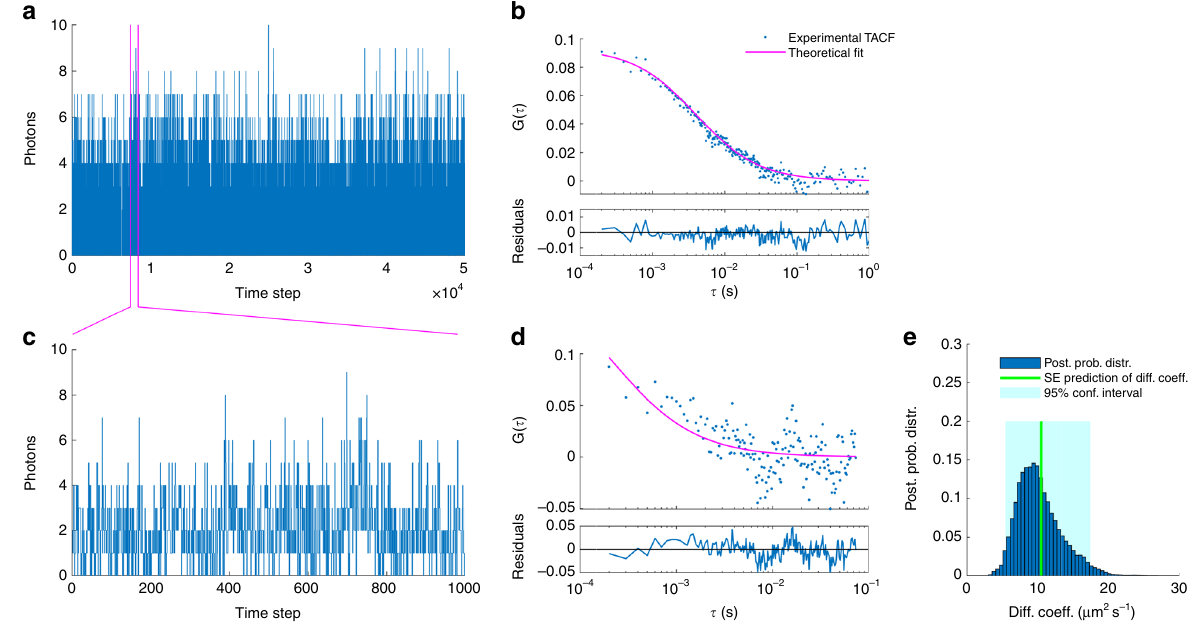
Fig. 4 Traces of free fl uorescent beads using an elongated confocal volume. a Experimental fl uorescent intensity trace used in FCS. b Autocorrelation curve of the trace in a and best theoretical fi t. c Portion of the trace in a to be used as the input to FCS and our method. d Autocorrelation curve of trace in c . e Posterior probability distribution over the diffusion coef fi cient estimated from the trace in c . The Stokes – Einstein prediction is denoted by a green line. Traces shown in a and c are acquired at 100 μ s for a total period of 5 μ s and 0.1 μ s, respectively. The laser power used to generate the trace a is 100 μ W (measured before the beam enters the objective). The estimate of diffusion coef fi cient resulting by autocorrelation fi tting in a matches with the Stokes – Einstein prediction (i.e., 10.5 μ m 2 s − 1 ); whereas, in d is almost 10-fold higher (~ 10 μ m 2 s − 1